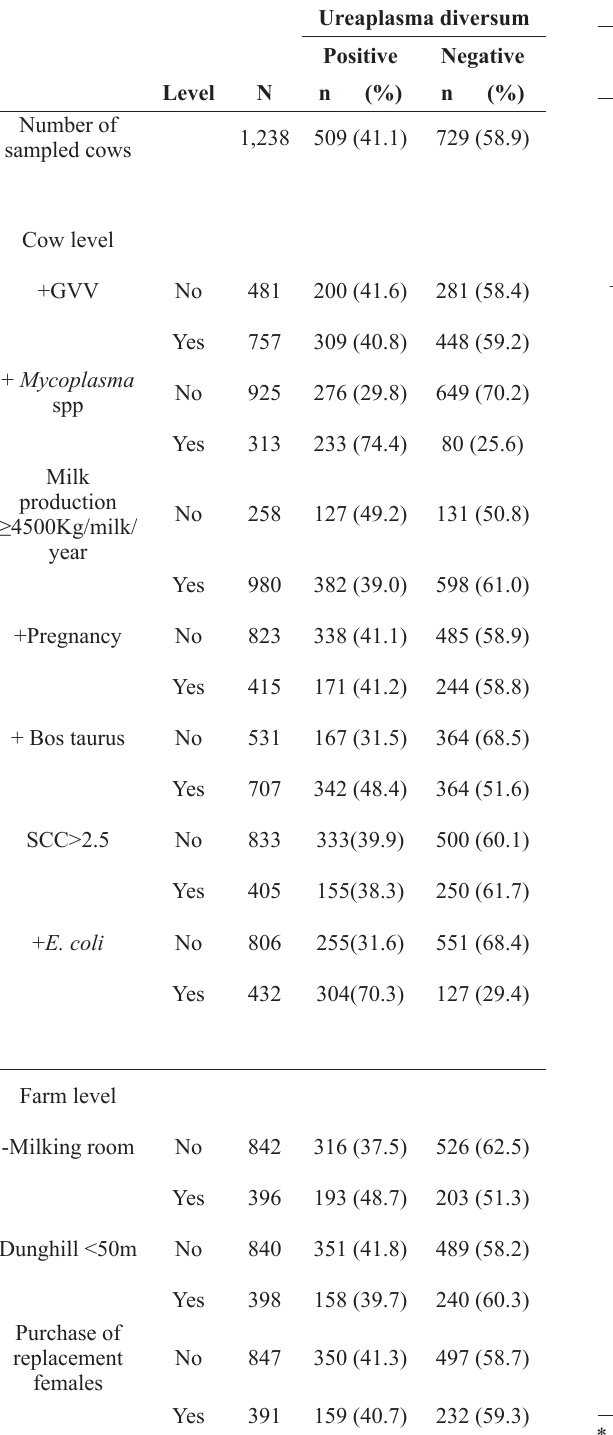
distribution of risk factors related to vaginal positive samples to Ureaplasma diversum on the 1,238 evaluated cows and 15 dairy farms systems.